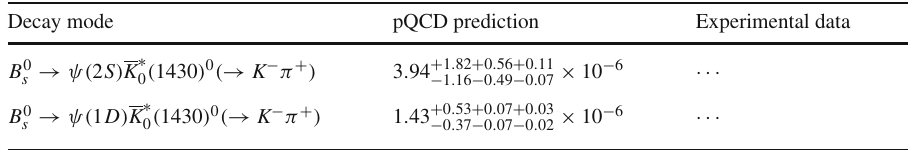
Table 4 Branching ratios of the P-wave resonances in the quasi-two-body decays B 0 s → calculated using the pQCD factorization